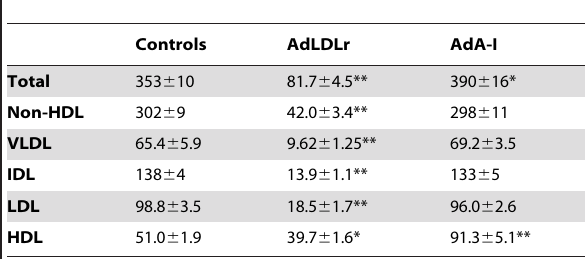
Table 1. Total and non-HDL, VLDL, IDL, LDL, and HDL plasma cholesterol (mg/dl) at day 14 after saline injection or gene transfer with 5 6 10 10 particles of Adnull (Controls), after gene transfer with 5 6 10 10 particles of AdLDLr, and after gene transfer with 5 6 10 10 particles of AdA-I in female C57BL/6 LDLr 2 / 2 mice fed a diet containing 0.2% cholesterol, 10% coconut